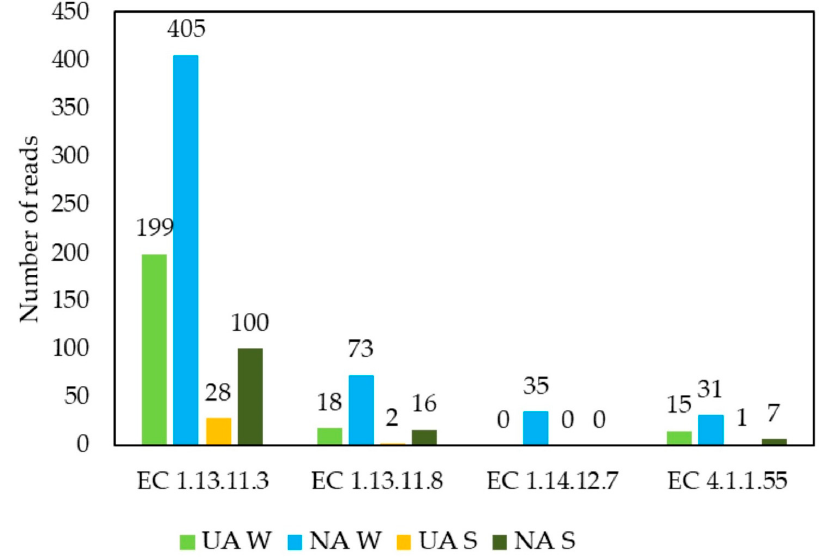
Figure 6. Barplot showing the average value, for each sample type (Urban Areas Winter-UA W; Natural Areas Winter-NA W; Urban Areas Summer-UA S; Natural Areas Summer-NA S), of reads number for genes involved in the synthesis of the enzymes protocatechuate 3,4-dioxygenase (EC 1.13.11.3), protocatechuate 4,5-dioxygenase (EC 1.13.11.8), phthalate 4,5-dioxygenase (EC 1.14.12.7), 4,5-dihydroxyphthalate decarboxylase (EC 4.1.1.55) revealed by the functional metagenomic analysis carried out on the microorganisms extracted from the leaf samples.